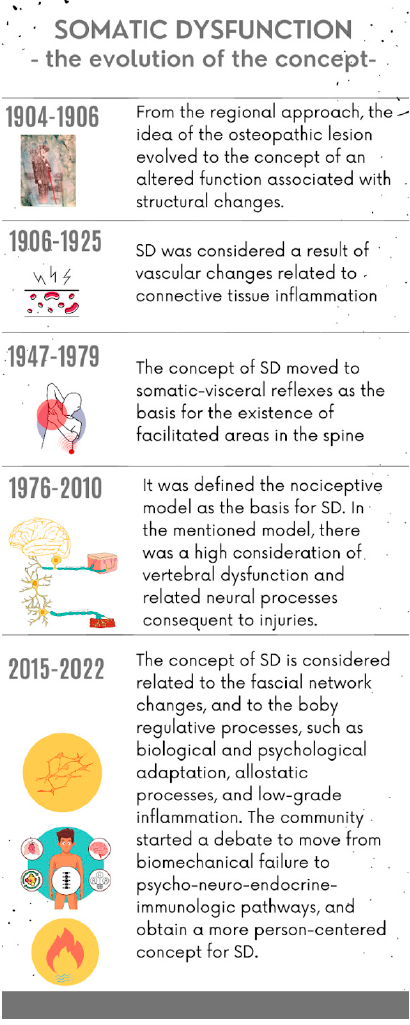
Figure 1. Somatic dysfunction: the evolution of the concept.